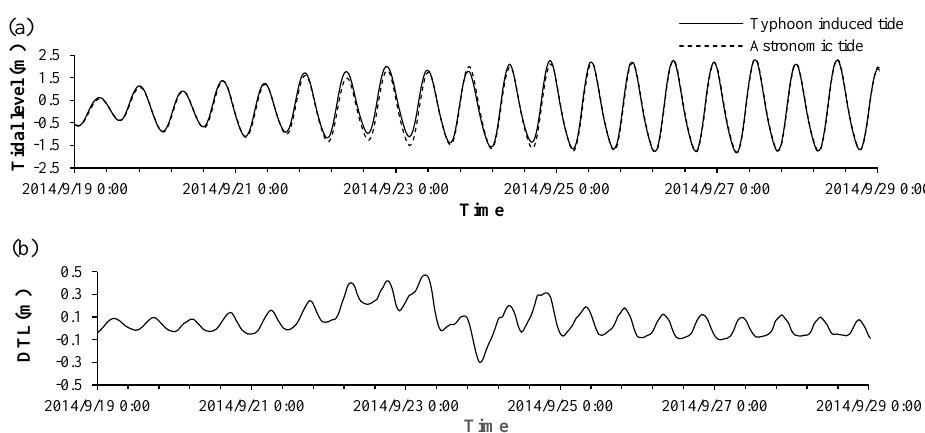
Figure 9. ( a )Time history of typhoon-induced and astronomic tidal levels; ( b ) the difference in tidal level (DTL) under Typhoon Fongwong and no-wind force action at NB1.